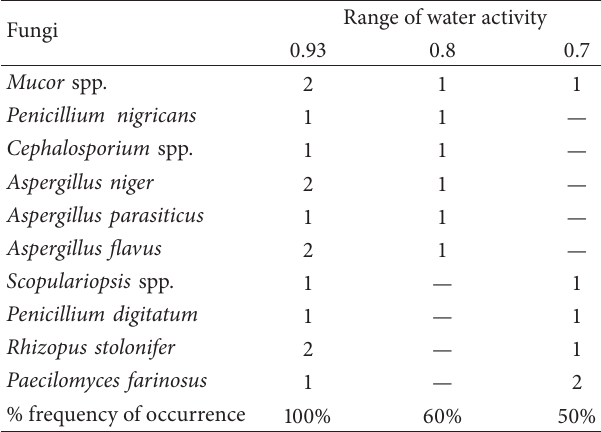
Figure 3: Moisture sorption isotherm of yellow garri at 20 ∘ C and 30 ∘ C. Table 3: Occurrence of mould isolates in garri at different water activity